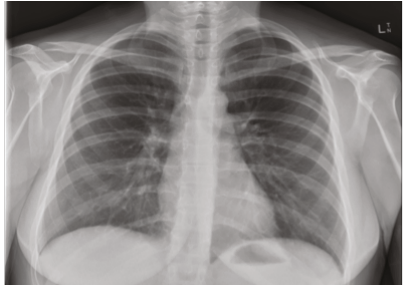
Figure 4: Normal CXR-resolution of free air in pleural spaces and